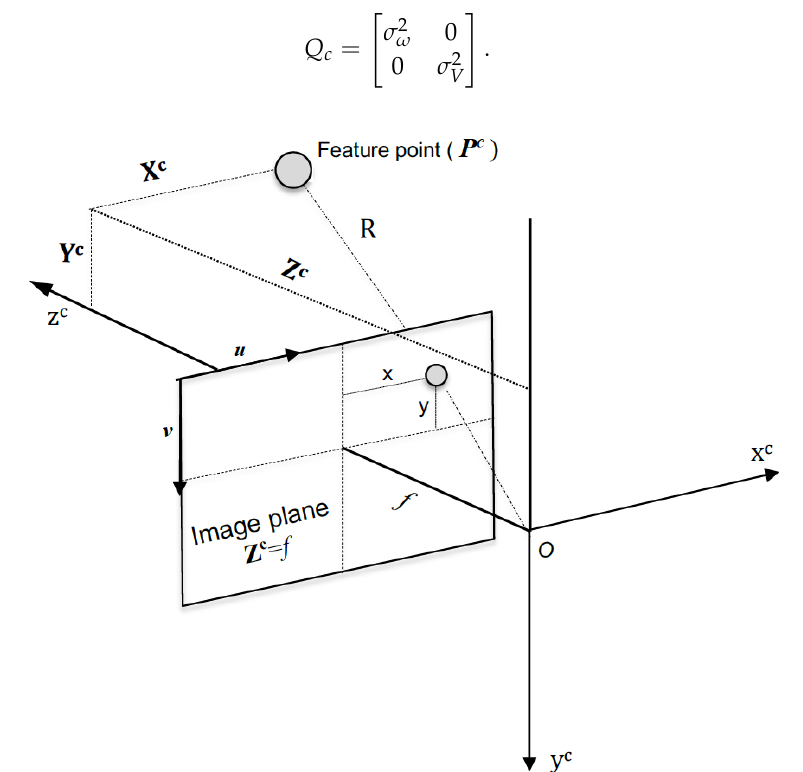
Figure 2. Projection of a feature point on the image plane. Reprinted from the work by the authors of